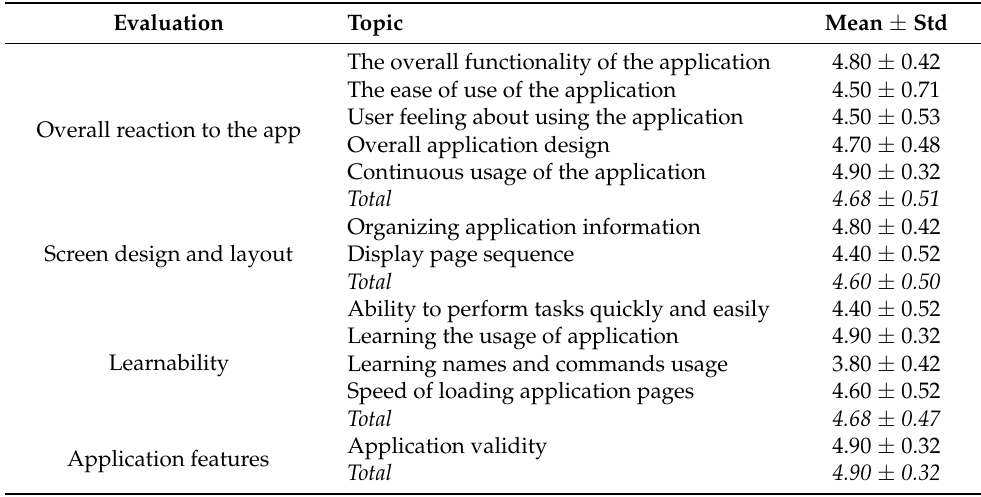
Table 3. Usability